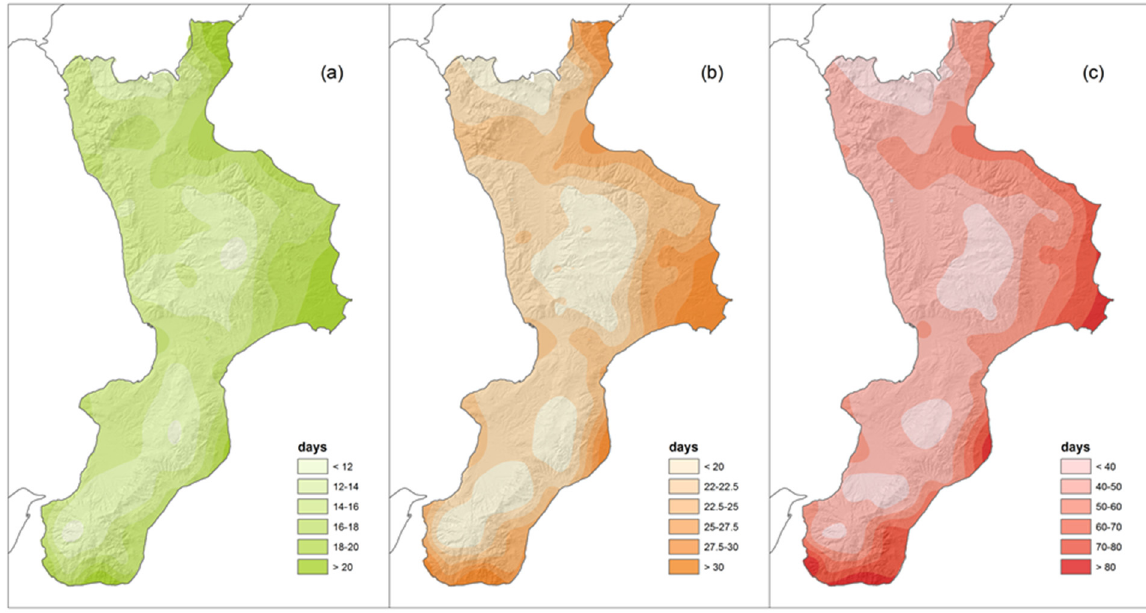
Figure 2. Spatial distributions of the ( a ) 90th; ( b ) 95th and ( c ) 99th percentiles of the dry spell